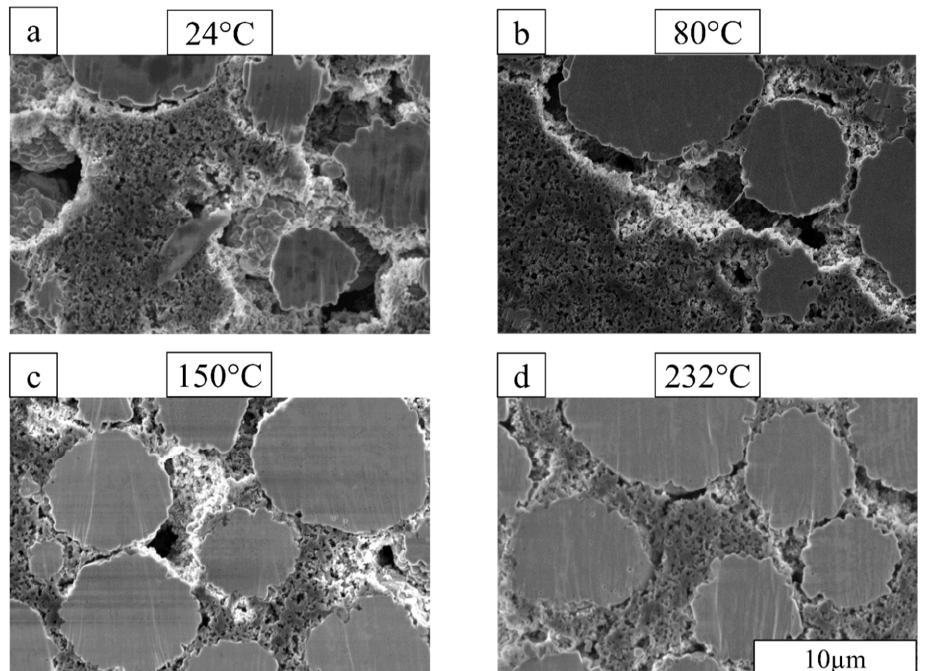
Figure 3. SEM images of the dried NMC cathodes at: ( a ) 24 °C; ( b ) 80 °C; ( c ) 150 °C; ( d ) 232 °C.